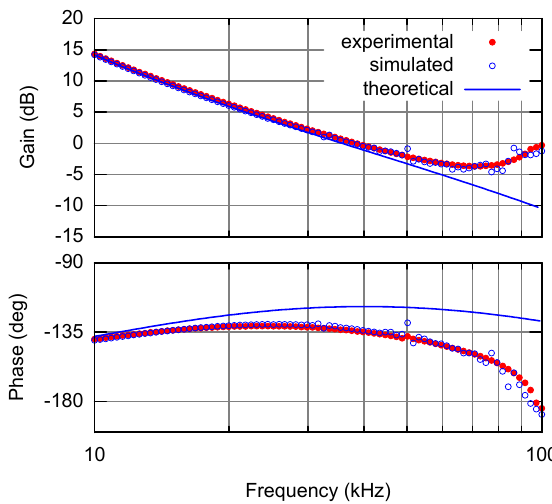
Figure 14. Theoretical, simulated and experimental Bode diagrams of the voltage loop gain in the buck converter.